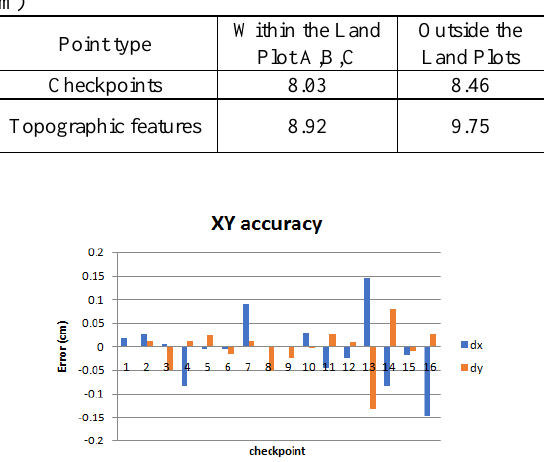
Figure 10: Z errors at